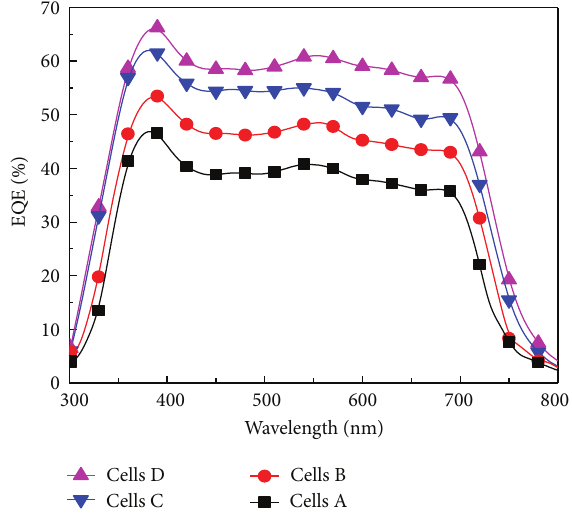
Figure 4: The EQE spectra of PSCs with various anode buffer layers.